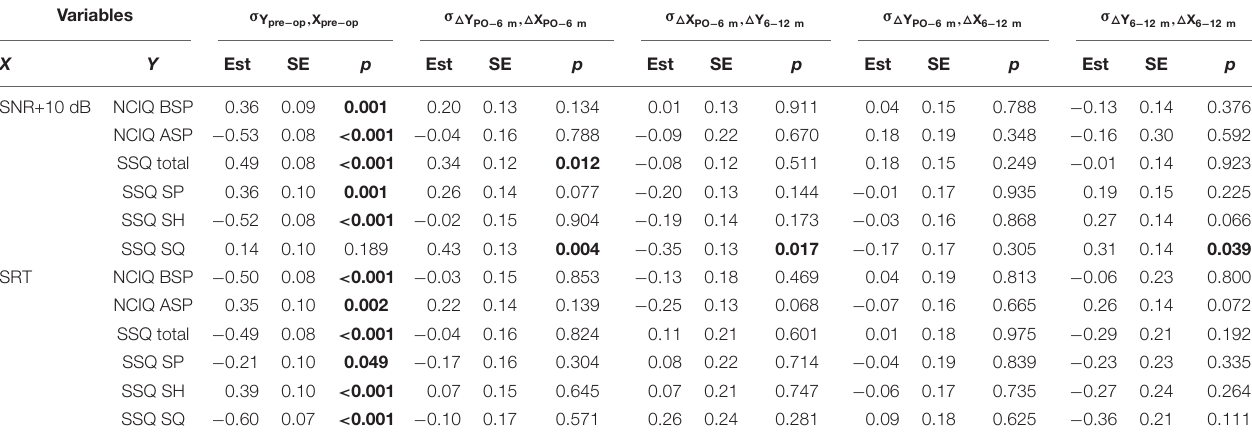
TABLE 3 | Standardized covariances between Speech-in-noise (SiN) scores and patient reported outcomes (PROMs) (bivariate latent change score models).